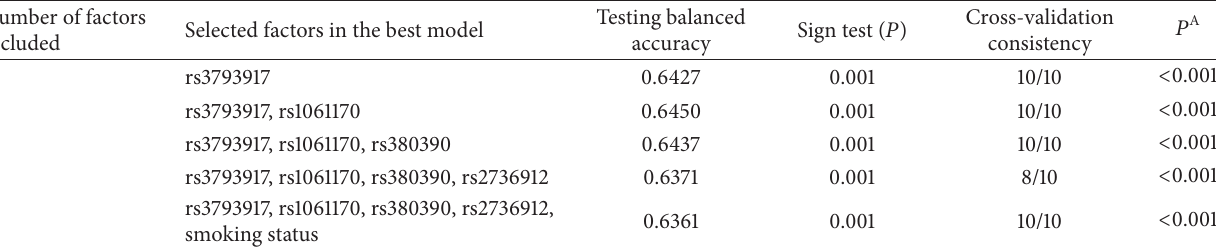
Figure 1: Association for nAMD with each of the five gene/environmental risk factors. Table 3: Selected models for nAMD using one to five factors by GMDR.